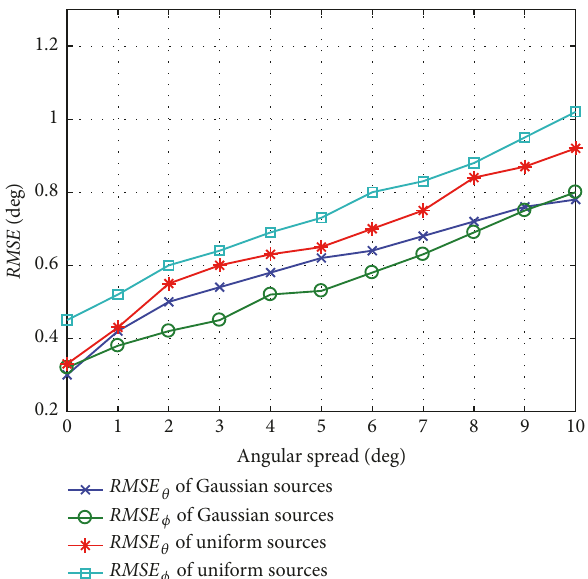
Figure 4: RMSE estimated for 2D ID sources with different angular